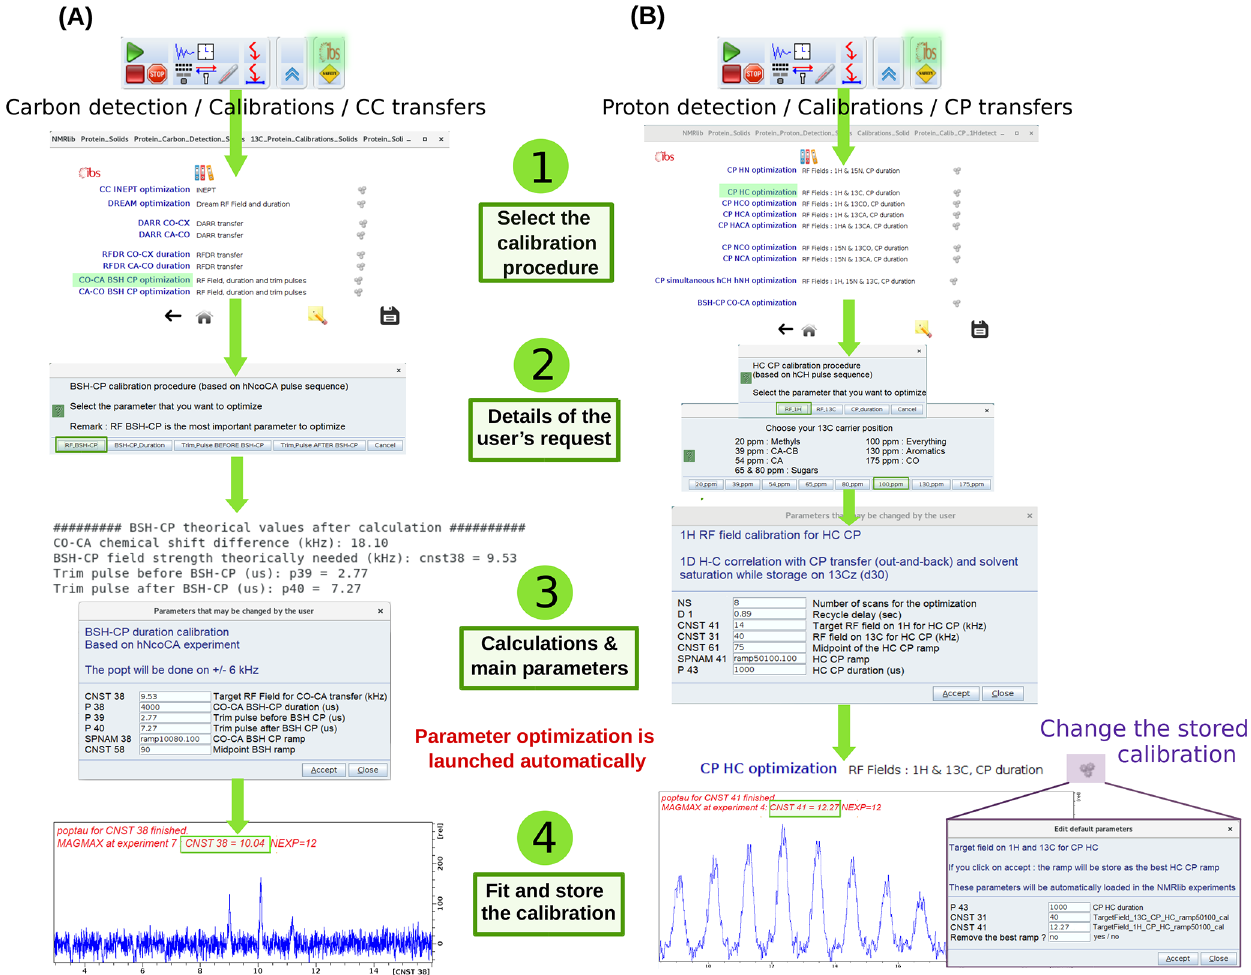
Figure 5. Optimization procedure of transfer steps. (a) Setup of BSH-CP CO-CA transfer optimization, found in carbon detection – cal- ibrations – CC transfers. Several parameters (RF field, durations, trim pulses) can be optimized. The theoretical values, calculated for the frequency offset and MAS frequency, are shown in the shell console and in a popup window. The optimized acquisition parameters after optimization are automatically stored and can be inspected by clicking on the cogwheel symbol (top windows). (b) Setup of 1 H- 13 C CP optimization. A choice of optimization parameters (RF field strengths, duration), different pre-defined ramps (e.g. linear 70–100 ramps) and carrier offsets is